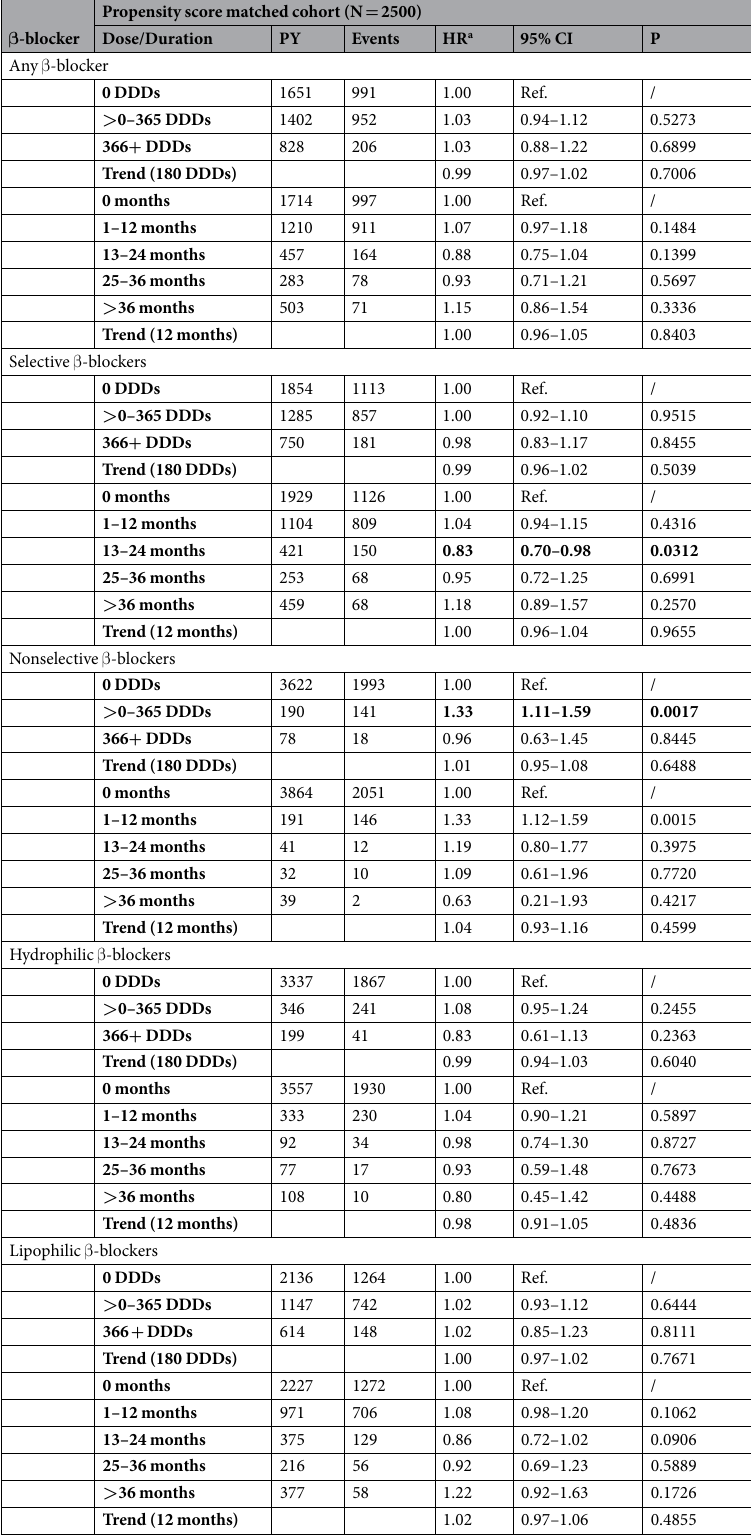
Table 4. Association between Post-diagnostic Cumulative Dose and Cumulative Duration of β -blocker use and Overall Lung Cancer Survival (Overall, by β -receptor Affinity and Pharmacokinetic Characteristics). Abbreviations: ATC = Anatomical Therapeutic Chemical Code, CI = Confidence interval, HR = Hazard ratio, PY = Person-years. a Hazard ratio from Cox proportional hazard model on the propensity score matched groups with additional adjustment for time-dependent use of Non-steroidal anti-inflammatory drugs, statins, antihypertensive (other than β -blocker) and diabetes medication after